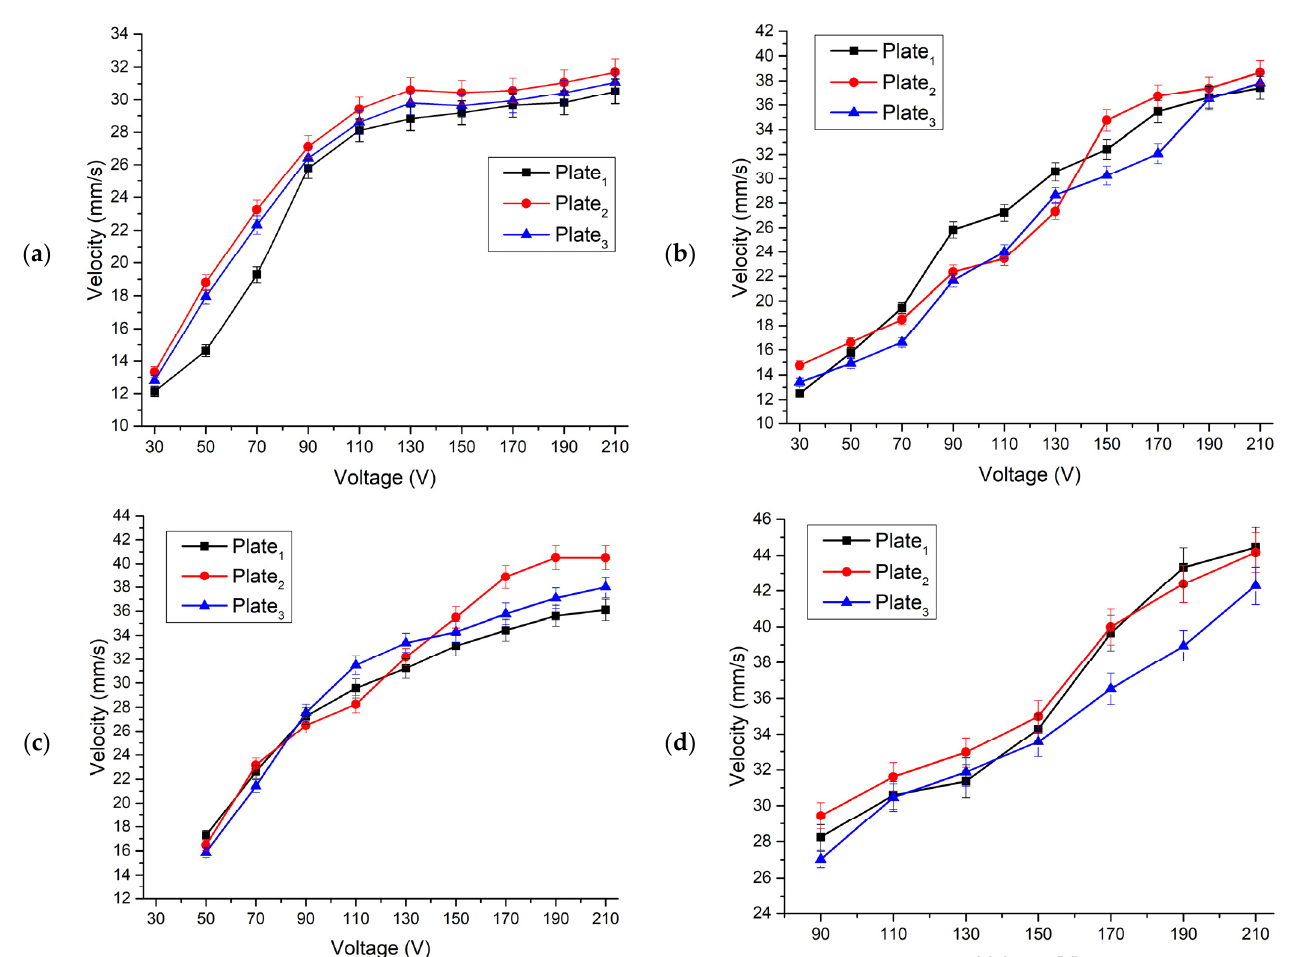
Figure 16. Velocity characteristics of the platform at different excitation voltages and load conditions; ( a )—velocity characteristics while the load is 6.96 g; ( b )—velocity characteristics while load is 12.05 g; ( c )—velocity characteristics while the load is 32.17 g; ( d )—velocity characteristics while load is 55.68 g.